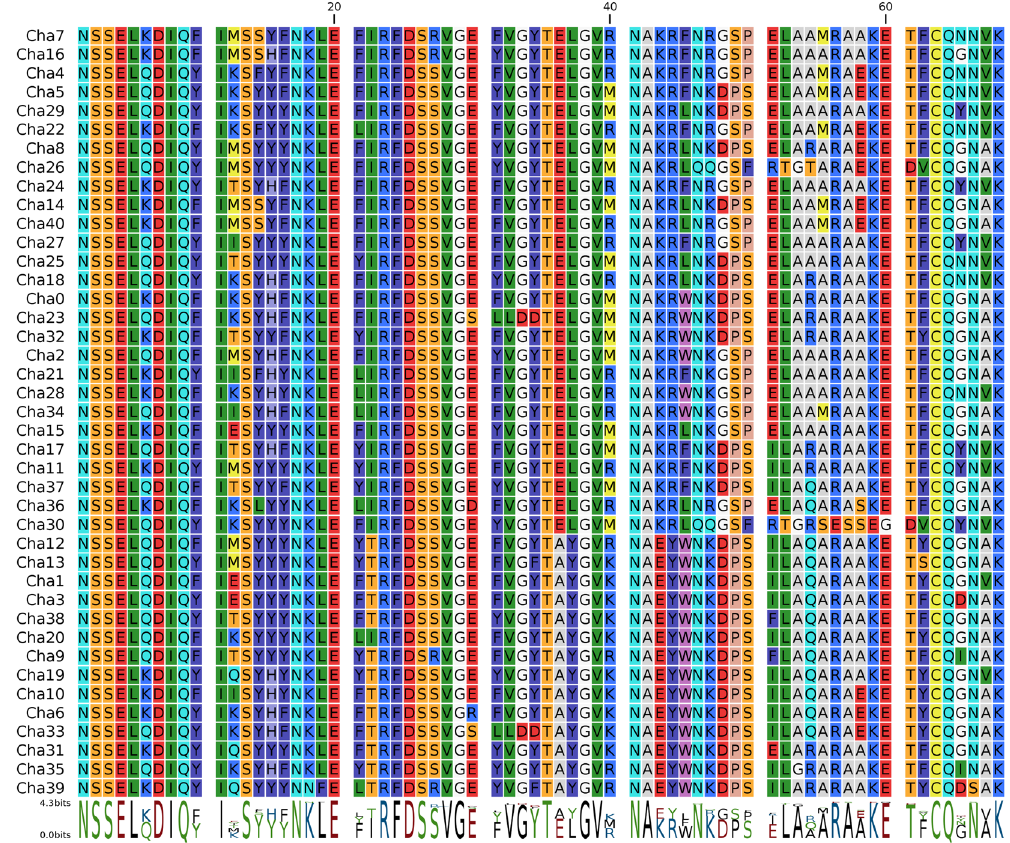
Figure 4. Multiple sequence alignment of the 41 translated non redundant DAB amino acid sequences, based on strict clustering (sequences sharing less than 3 non-synonymous SNPs have been collapsed in a single consensus sequence). Sequence conservation is indicated below the multiple sequence alignment with a conservation